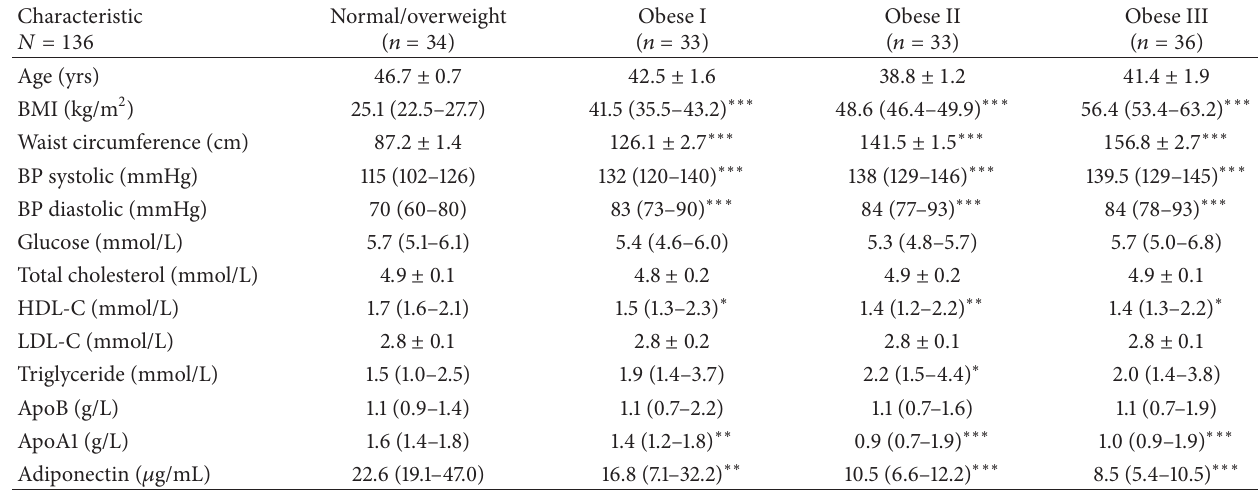
Table 1: Anthropometric and plasma variables of normal/overweight and obese groups. Characteristic 𝑁 =